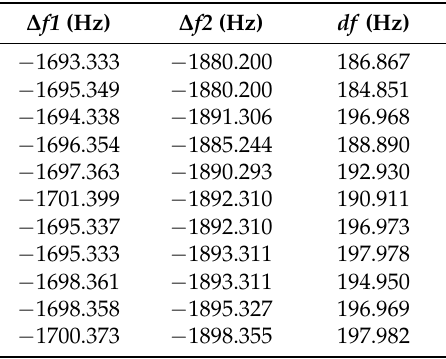
Table 1. ∆ f in 11 groups of temperature Table 1. Δ f in 11 groups of temperature cycles.